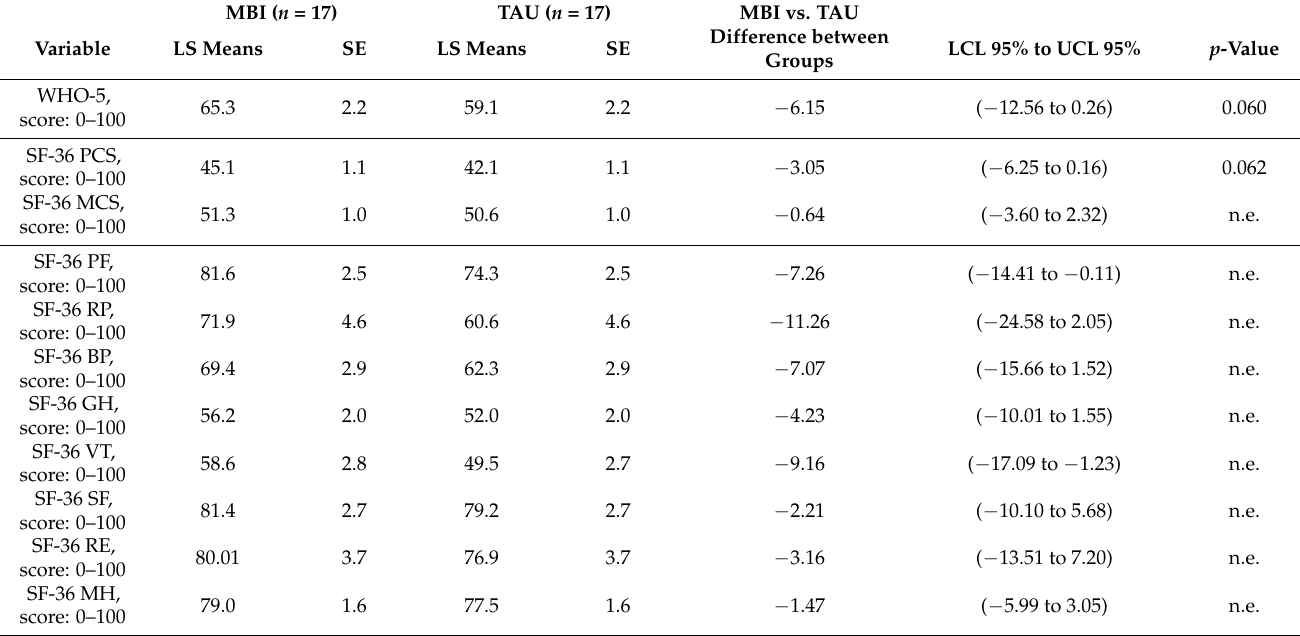
Table 2. Primary and key secondary outcomes during (across) the 26-week trial period. MBI ( n = 17) TAU ( n = 17) MBI vs.